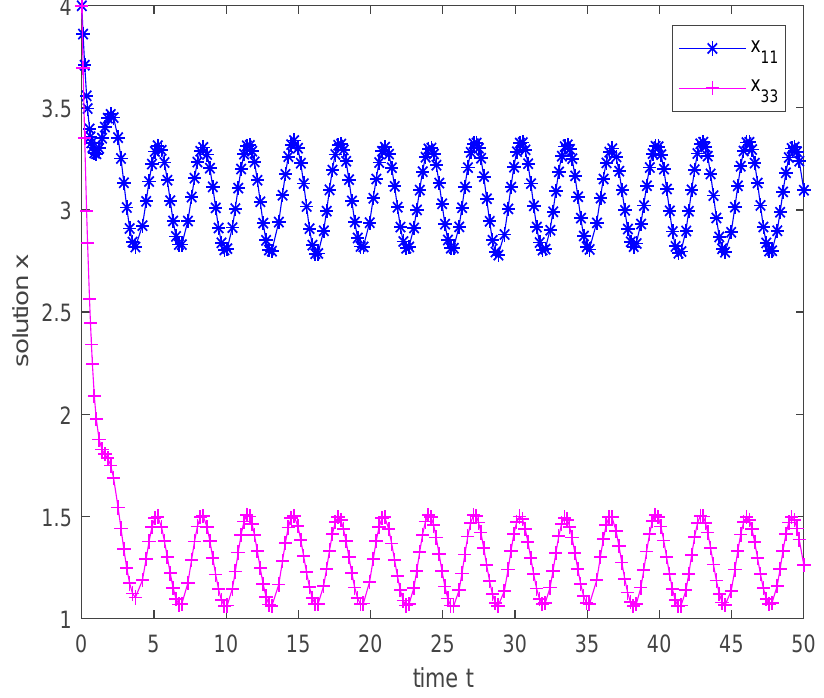
Figure 5. The state trajectory of x 11 and x 33 , and initial values are x 11 ( 0 ) = x 33 ( 0 ) =